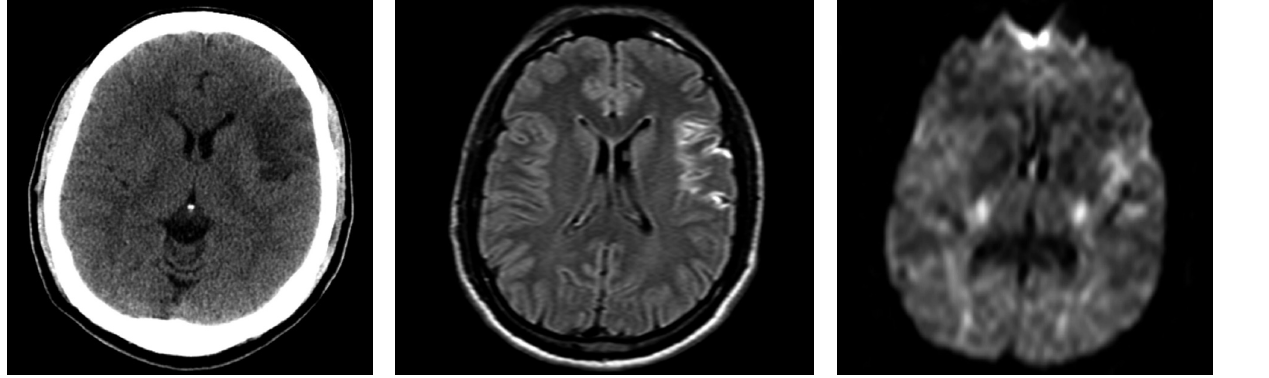
Figure 1. Cranial Computed Tomography in axial section showing hypodense area in the left inferior frontal gyrus topography.